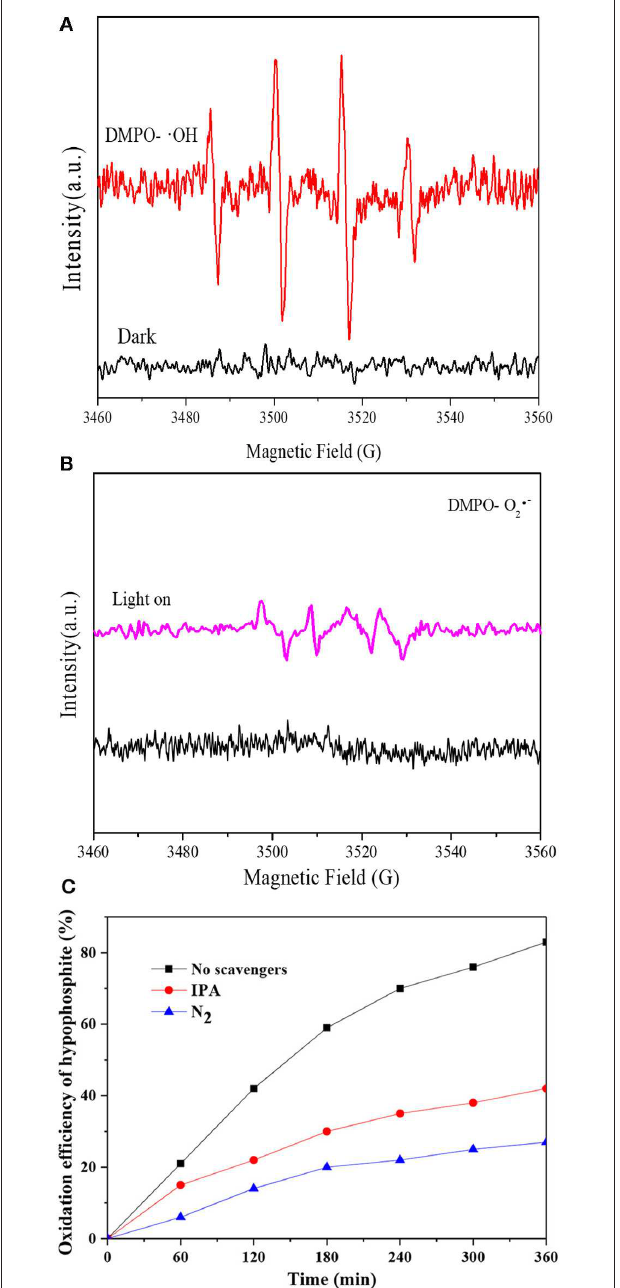
FIGURE 8 | Radials analyses. (A) DMPO spin-trapping ESR spectra for · OH radials analysis; (B) DMPO spin-trapping ESR spectra for · O 2 − radials analysis; (C) Effect of scavengers on the photocatalytic oxidation process.